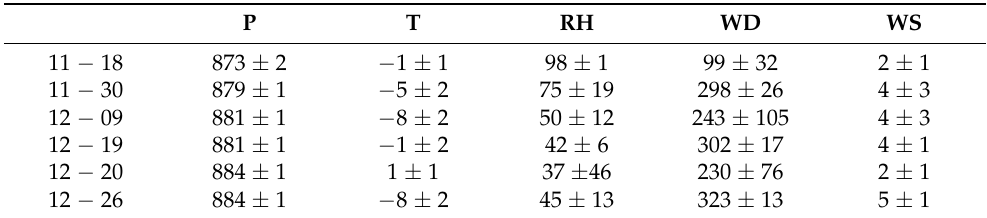
Table 2. Variation in meteorological parameters for the six study days. The P, T, RH, WD, and WS stand for pressure (hPa), temperature ( ◦ C), relative humidity (%), wind direction ( ◦ ) and wind speed (m/s), respectively. P T RH WD WS 11 − 18 873 ± 2 − 1 ± 1 98 ± 1 99 ± 32 2 ± 1 11 − 30 879 ± 1 − 5 ± 2 75 ± 19 298 ± 26 4 ± 3 12 − 09 881 ± 1 − 8 ± 2 50 ± 12 243 ± 105 4 ± 3 12 − 19 881 ± 1 − 1 ± 2 42 ± 6 302 ± 17 4 ± 1 12 − 20 884 ± 1 1 ± 1 37 ± 46 230 ± 76 2 ± 1 12 − 26 884 ± 1 − 8 ± 2 45 ± 13 323 ± 13 5 ±